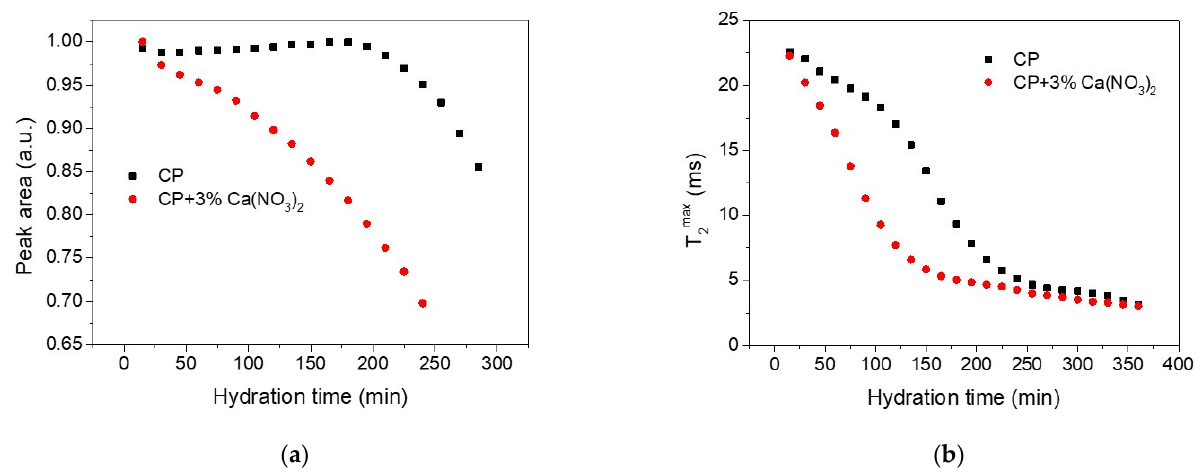
Figure 3. ( a ) The peak area evolution during hydration for the capillary pores of the two samples; ( b ) Evolution of the relaxation time corresponding to the peak maximum during the hydration.